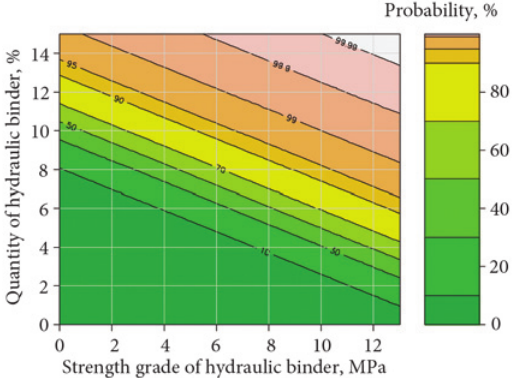
Fig. 2. Contour map of probability of conformity of the compressive strength condition by a soil-binder mixture made from soil No. 1 tested after 42 days (2.5 MPa ≤ R c 42 ≤ 5.0 MPa), with consideration of the frost resistance coefficient n ( n ≥ 0.7)